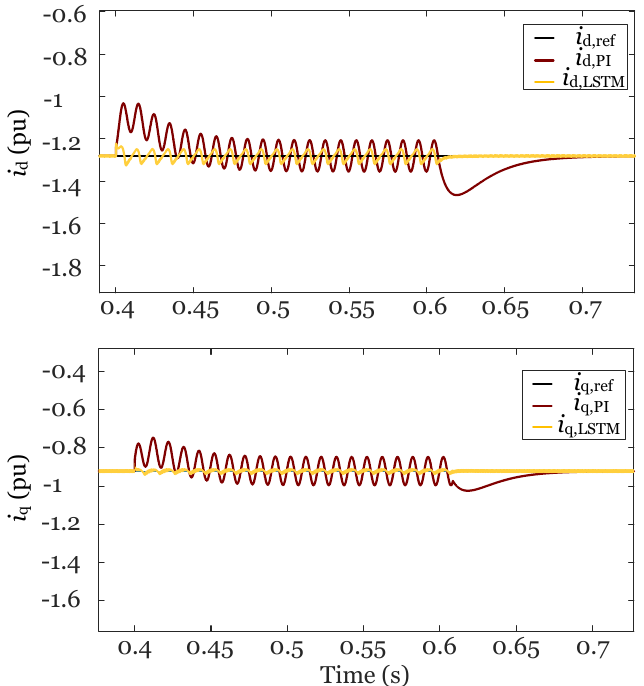
Figure 12. Controller response to a phase-phase fault at PCC.